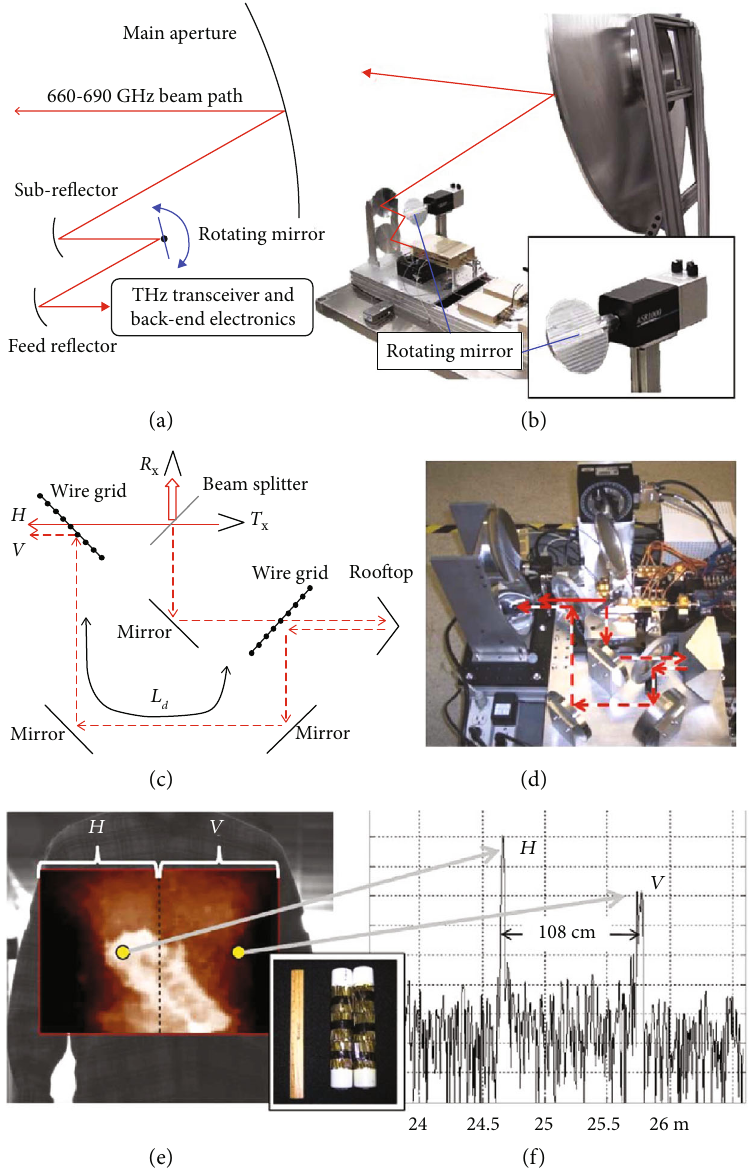
Figure 3: Radar information screening device and results